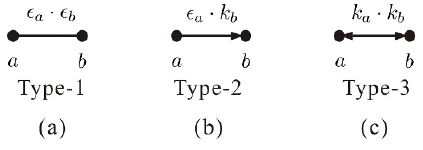
Figure 3 . Three types of lines between